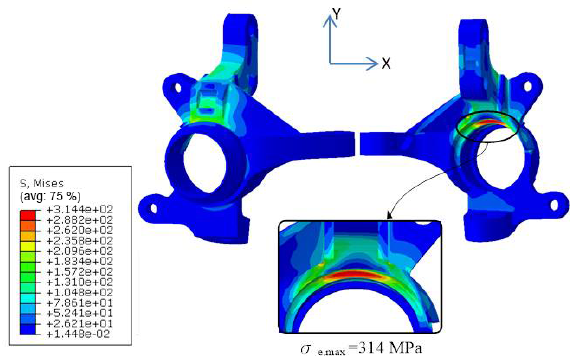
Figure 15. Von Mises stress distribution of knuckle under impact load conditions.